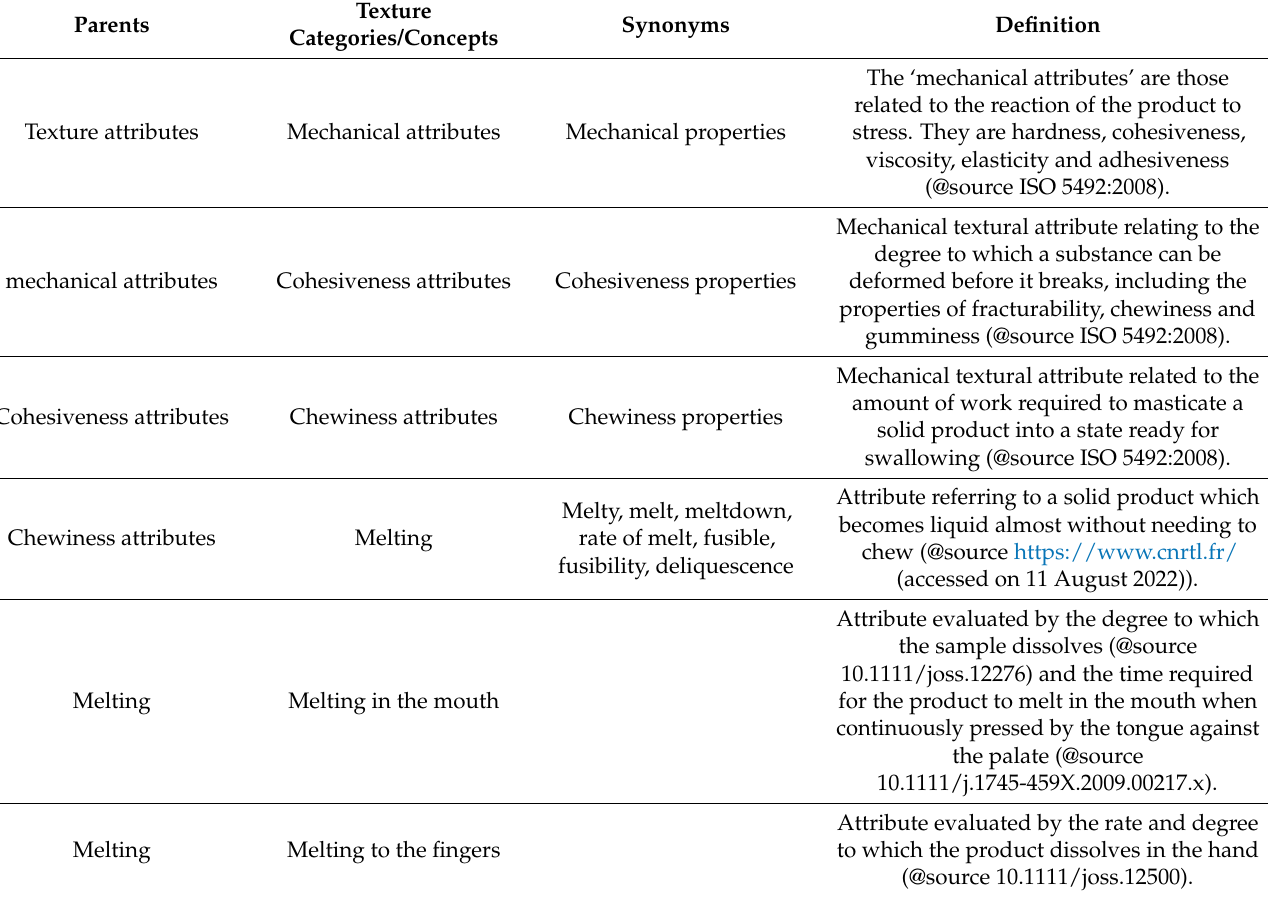
Table 7. Overview of definitions of categories related to classification of concept ‘melting’ and definitions of concept and variations, presented in alphabetical